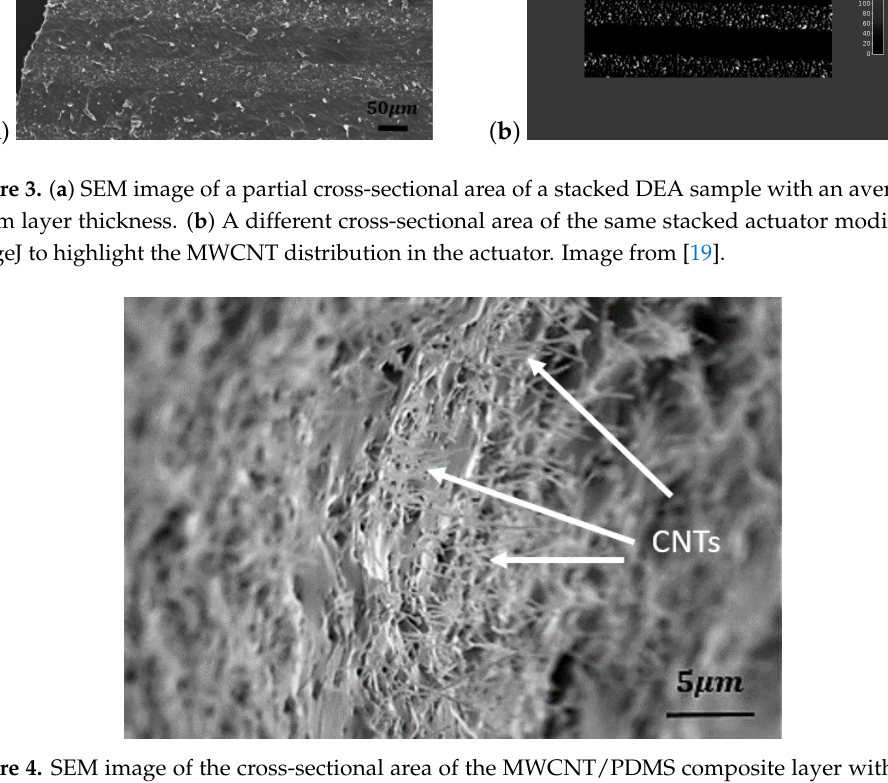
Figure 4. SEM image of the cross-sectional area of the MWCNT/PDMS composite layer within the stacked actuator structure, zoomed at a shallow angle to highlight the presence of carbon